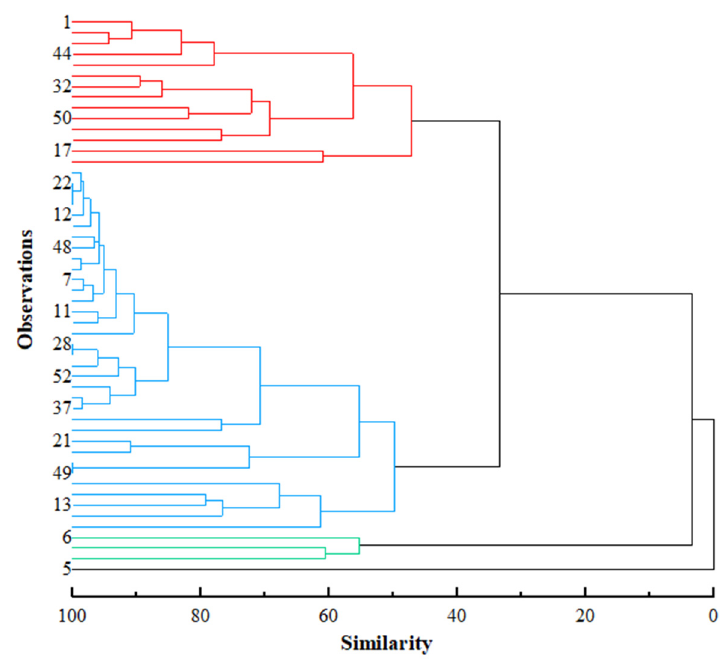
Figure 2. Systematic clustering results of expert group eigenvectors.